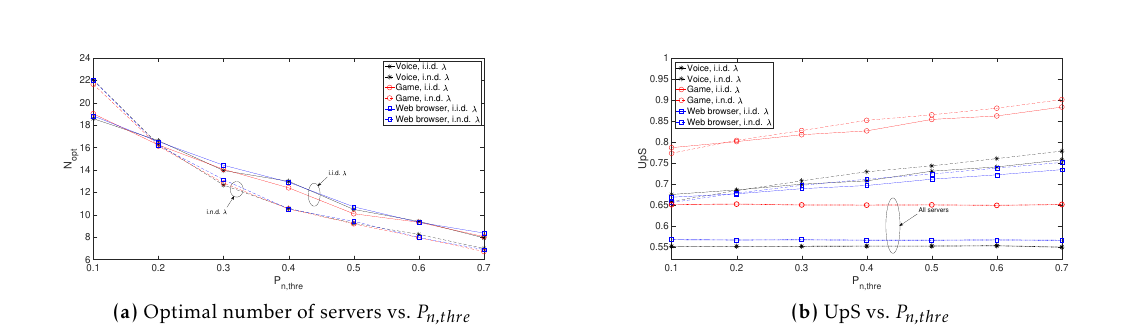
Figure 6. Impacts of latency requirements in different services